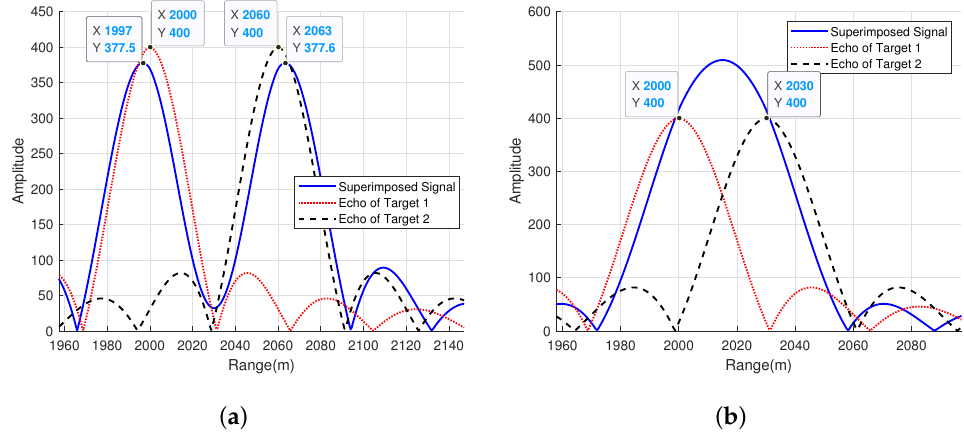
Figure 5. Simulation of the superimposed signal. ( a ) The distance between two targets is 60 m. ( b ) The distance between two targets is 30 m.